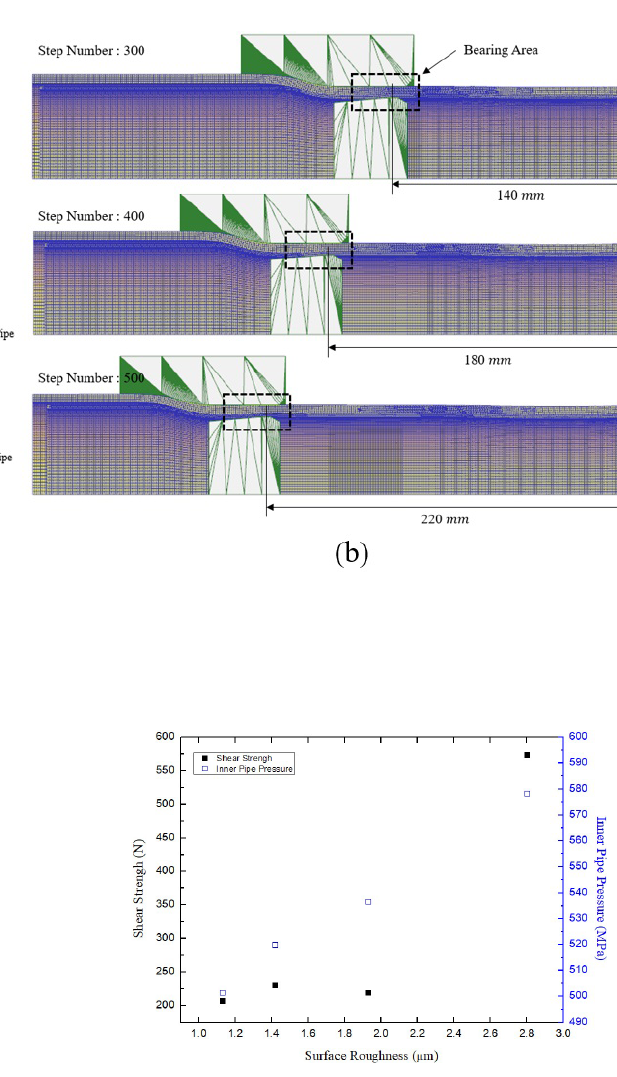
Figure 15. Comparison of inner pipe pressure and shear strength.